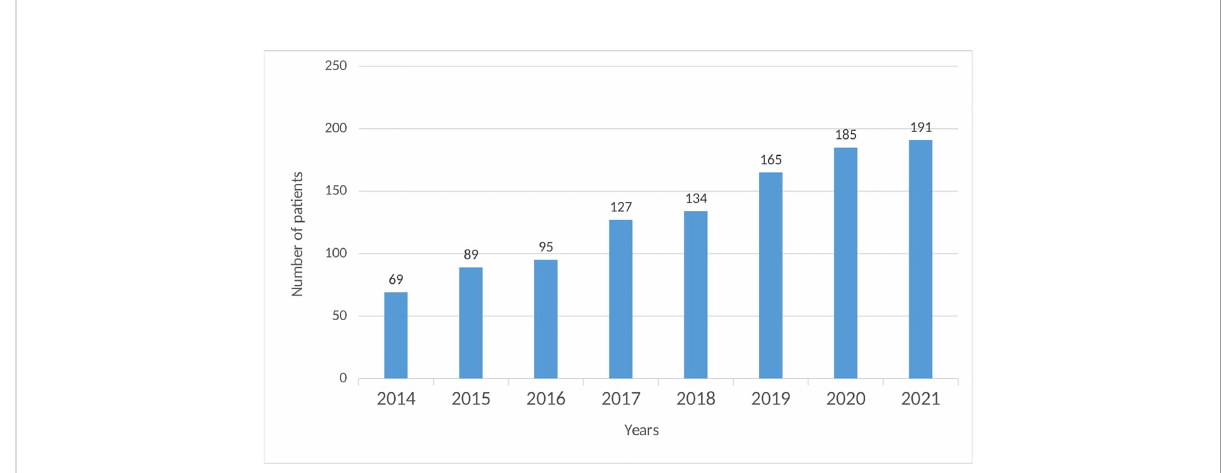
FIGURE 1 Distribution of the number of patients in the National PID Expert Center by